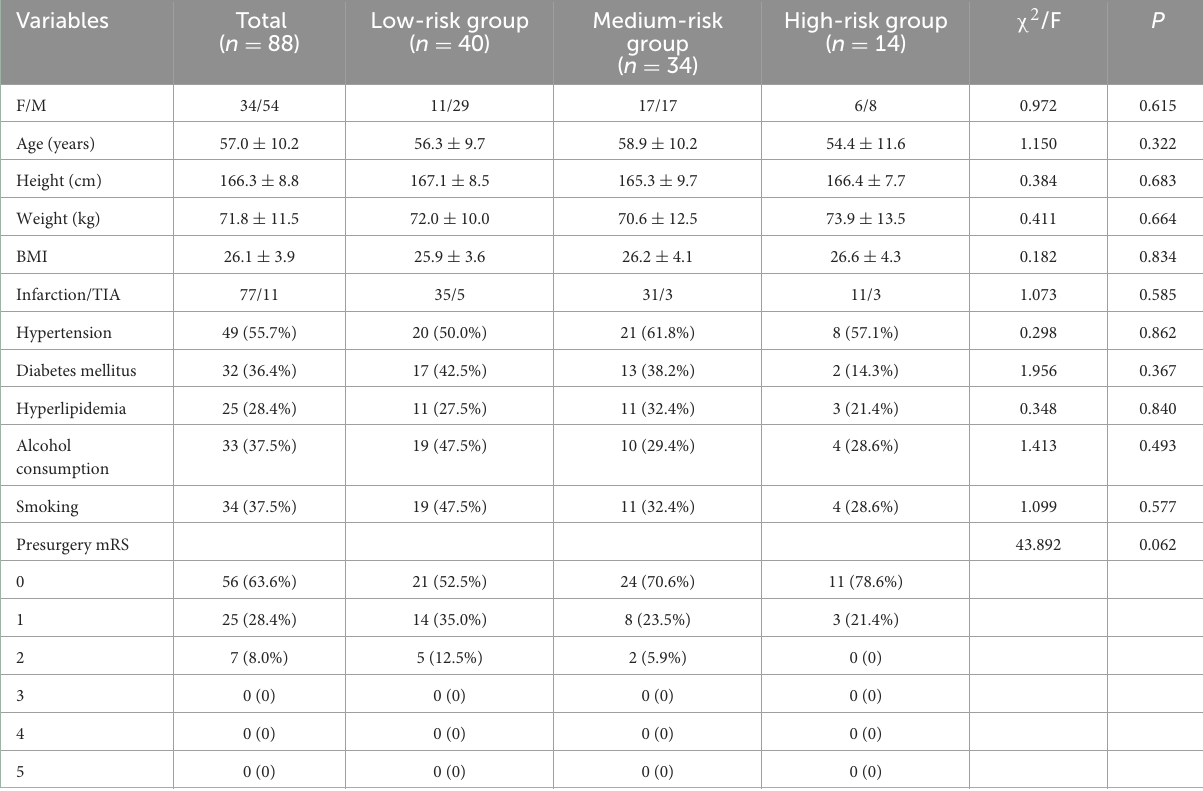
TABLE 2 Baseline characteristics of 88 patients with